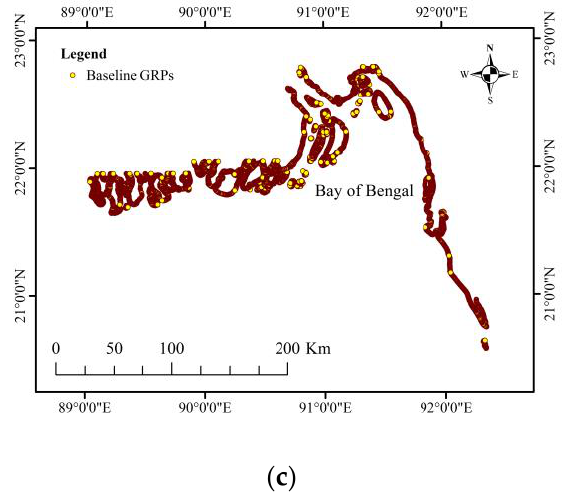
Figure 11. Baseline assessment and validation by ground reference points (GRPs) using the SoB- provided country datasheet of Bangladesh: ( a ) create coastal baseline, ( b ) point and line features intersection of baseline, and ( c ) total 16,550 baseline GRPs.